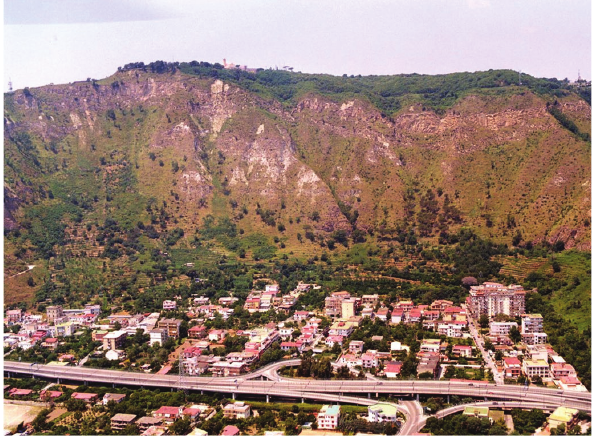
Fig. 1. The borough of Soccavo and the southern slope of the Camaldoli hill, Naples, Italy.